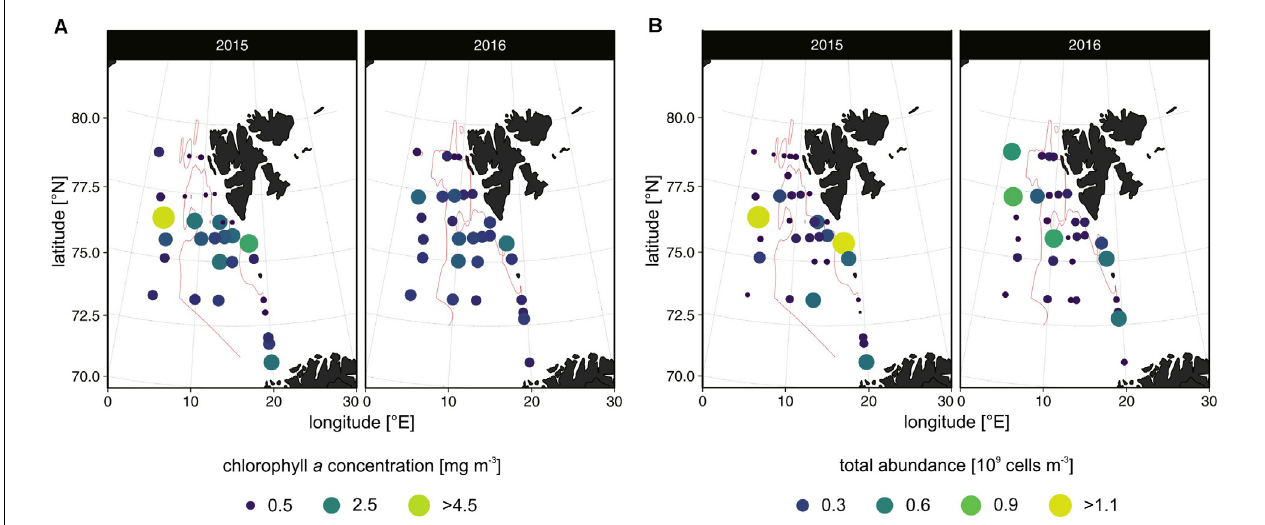
FIGURE 3 | The extracted chlorophyll a concentrations [mg m - 3 ] (A) and total protist abundance [10 9 cells m - 3 ] (B) at the stations in the summers of 2015 and 2016. Only values higher than 0.5 mg m - 3 and 0.3 × 10 9 cells m - 3 are included in the legend. The 6 ◦ C isotherm is marked with the solid line (also in Figure 6C ).